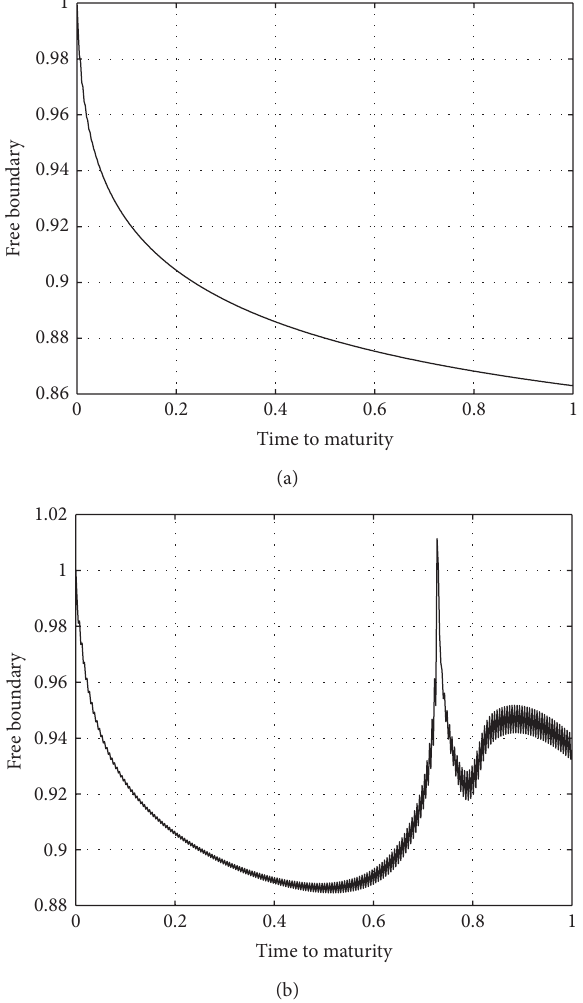
Figure 1: Dependence of stability on positivity of coefficient 𝑏 . ( 𝜇 = 24 , 𝑏 = 0.0398 ) for (a) and ( 𝜇 = 25.2 , 𝑏 = −0.0083 ) for